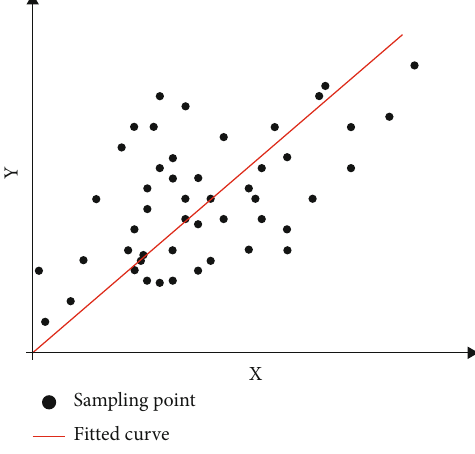
Figure 5: PROSAC random sampling